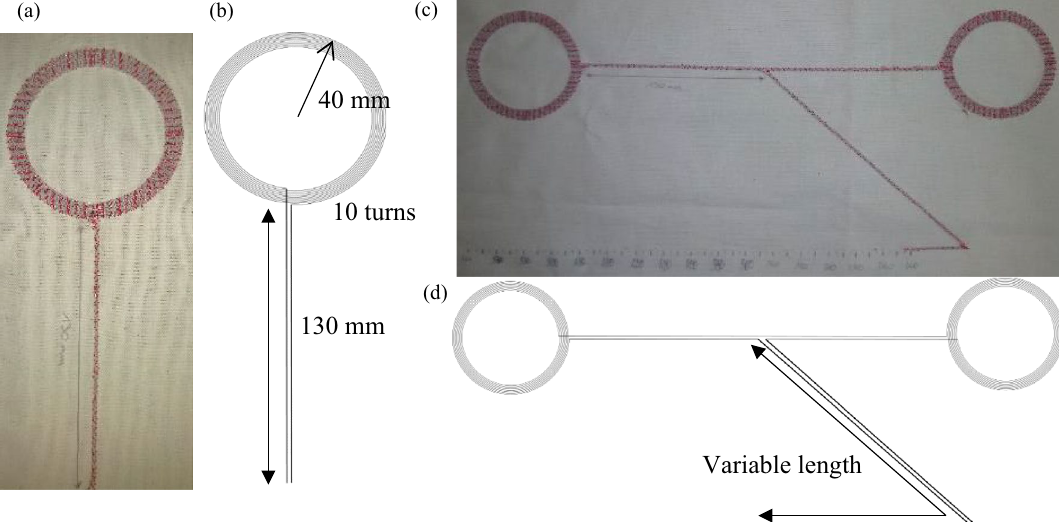
Figure 1. ( a ) Photography of the antenna and ( b ) its diagram. ( c ) Photography of the two antennas textile dual- band (NFC-A4WP) combiner and ( d ) its diagram. Figure 1( b ) and ( d ) were carried out using Inkscape software v1.2.2 (https:// inksc ape.